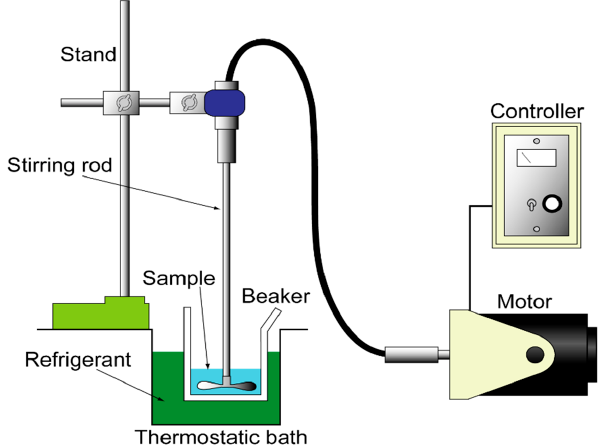
Figure 1. Apparatus for producing ice slurry.